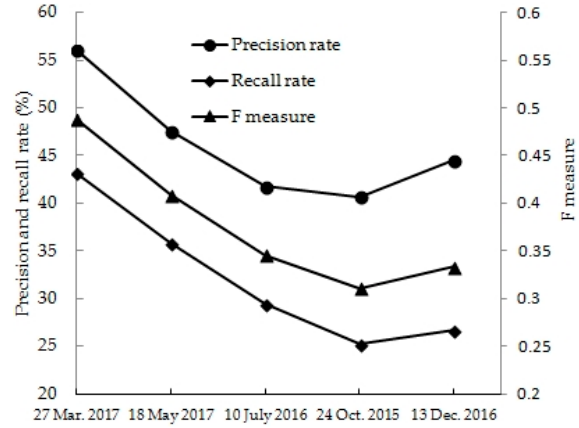
Figure 4. Precision rate, recall rate, and F measure values for the QVP detection from five singe seasonal images using the five predictive variable selection datasets listed in Table 4.